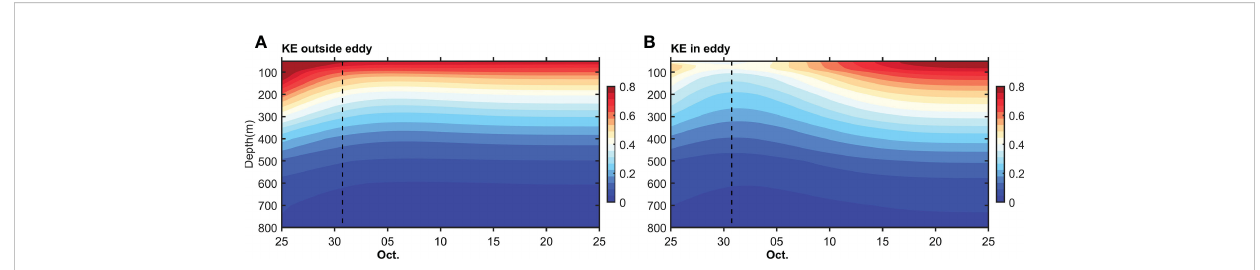
FIGURE 9 KE of background fl ow outside (A) and in (B) the eddy (unit: J/m 3 ). The black dashed lines represent the time when MITAG left the sea area east of Taiwan (18:00 30